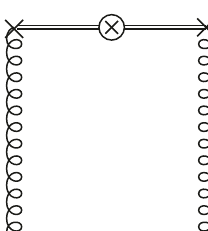
denotes the mass counter-term of N